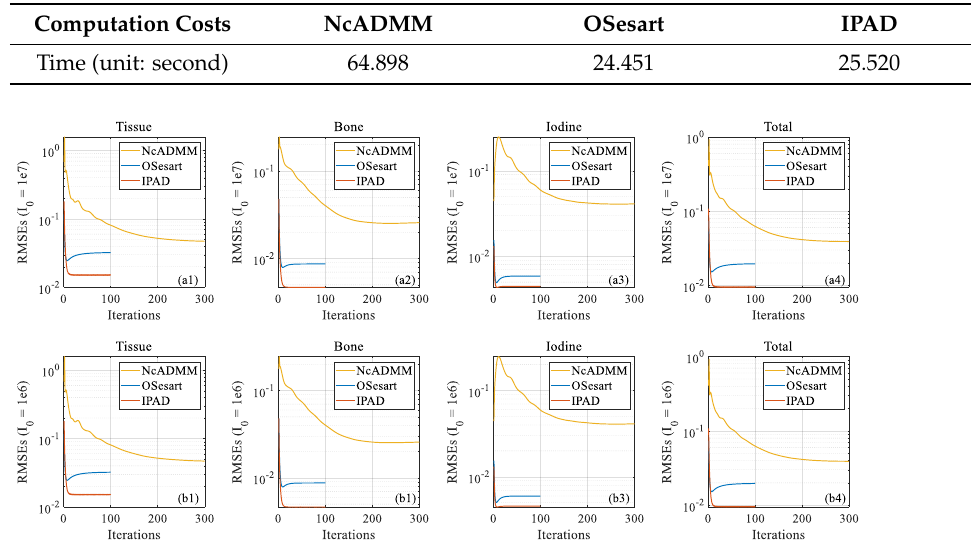
Table 2. Computation costs of three iterative algorithms for one iteration.